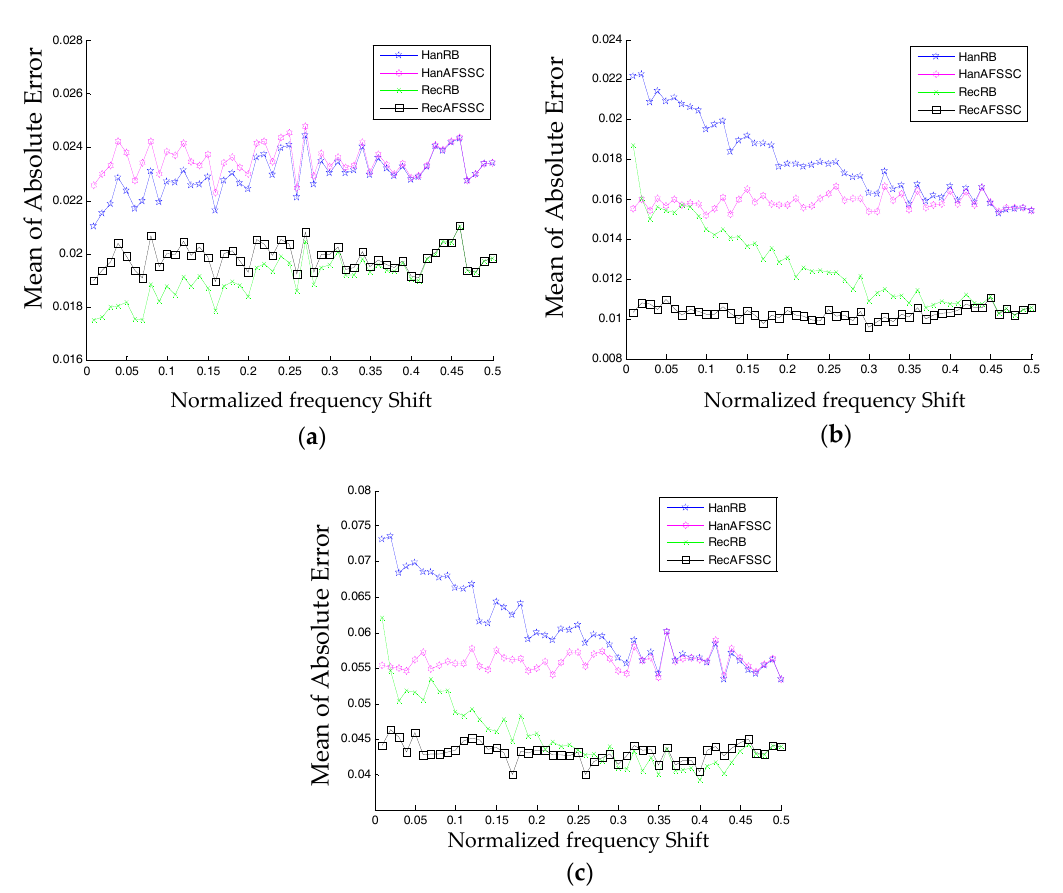
Figure 13. Comparisons on the comparison of four comparison methods with respect to information of ( a ) amplitude, ( b ) frequency, and ( c ) phase.